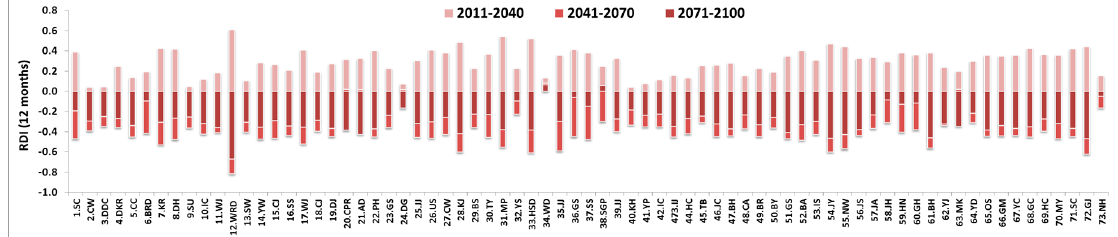
Figure 9. Results of drought index at each observatory using RDI.